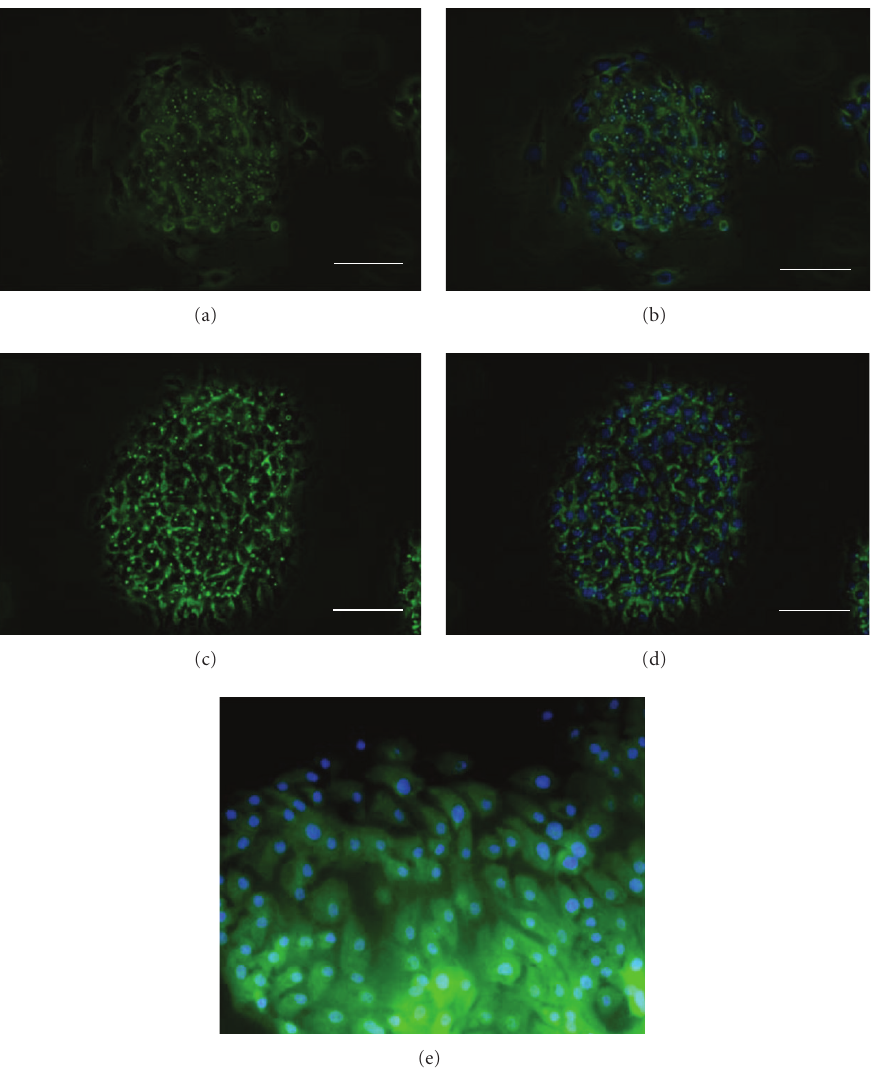
Figure 4: Immunofluorescence analysis in enamel organ-derived epithelial (EOE) cells. (a) Immunofluorescence showed that EOE cells were positive for amelogenin in the collagen type I-coated dishes. (b) Merged image to (a). Amelogenin staining in combination with DAPI to stain DNA (blue). (c) EOE cells were positive for amelogenin by immunofluorescence in the insulin-like growth factor-I/insulin-like growth factor binding protein-3/vitronectin complex-coated dishes. The staining of amelogenin in the EOE cells was more intense than that in the collagen type I-coated dishes. (d) Merged image to (c). Amelogenin staining in combination with DAPI to stain DNA (blue). Scale bars: 50 μ m length (a–d). (e) The high magnification view of (d). EOE cells cultured on in the insulin-like growth factor-I/insulin-like growth factor binding protein-3/vitronectin complex-coated dishes expressed strongly